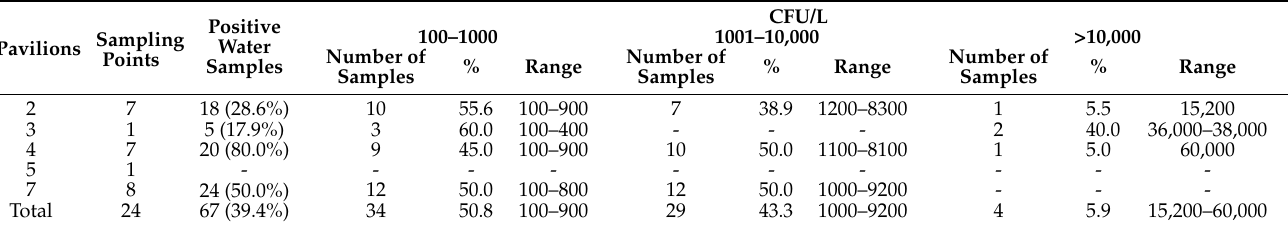
Table 1. Summary of the results characterizing the contamination of water systems by Legionella spp. in the examined pavilions and in the different sampling points. Positive water samples, divided for the various levels of CFU/L, are presented in whole numbers and